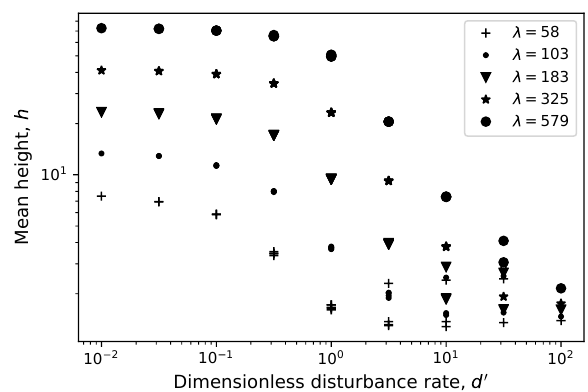
Figure 9. Dimensionless mean hillslope height, h , as a func- tion of dimensionless disturbance rate d (cid:48) for a range of hillslope lengths. Data points include 125 sensitivity analy- sis runs in which d ∈ [ 10 − 3 , 10 − 2 . 5 , 10 − 2 , 10 − 1 . 5 , 10 − 1 ] , τ ∈ [ 10 2 , 10 2 . 5 , 10 3 , 10 3 . 5 , 10 4 ] , and λ as shown in the